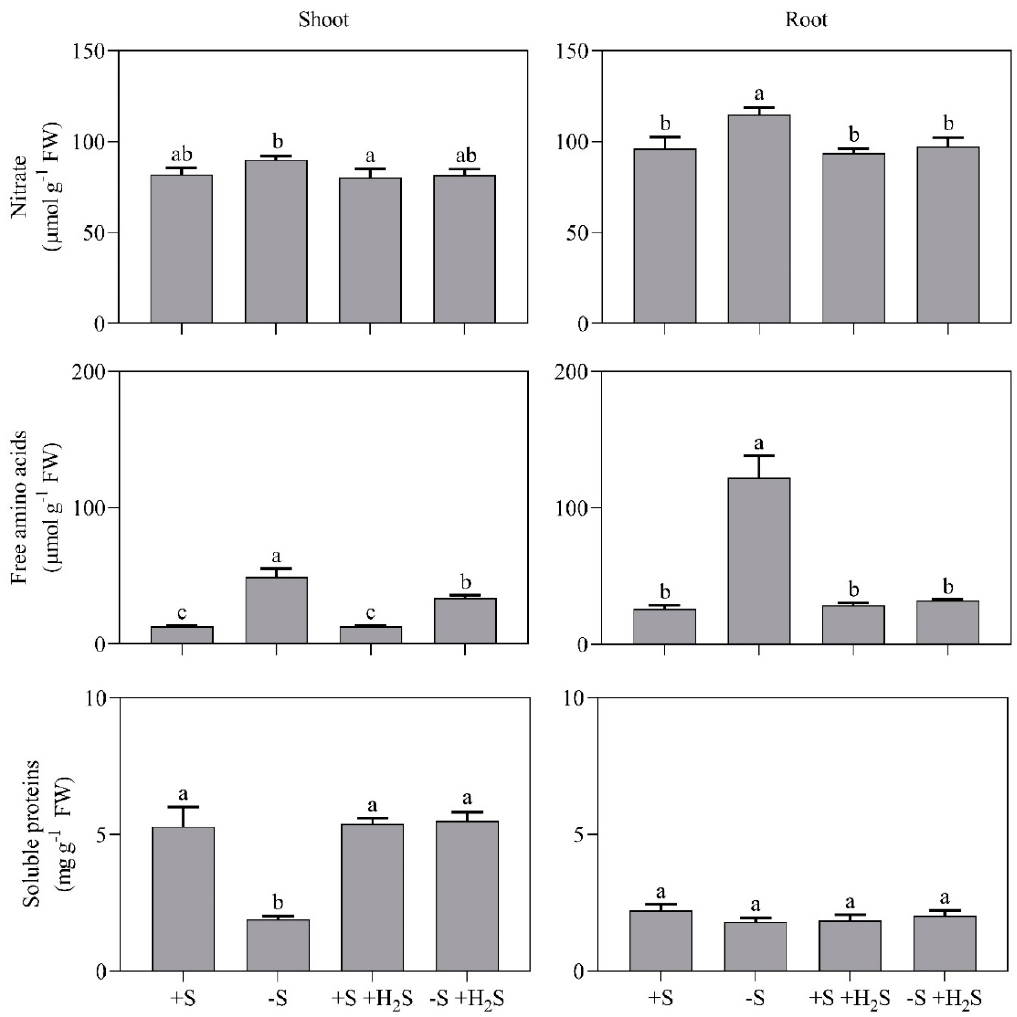
Figure 3. Nitrate, free amino acid and soluble protein content of barley shoots and roots in the presence and absence of a H 2 S and sulfate supply. For experimental details, see the legend of Figure 1. Data represent the average of 3 measurements with 3 plants per measurement ( ± SD). Significant di ff erences between treatments are indicated with di ff erent letters ( P ≤ 0.05; two-way ANOVA; Tukey’s HSD test as a post-hoc test).